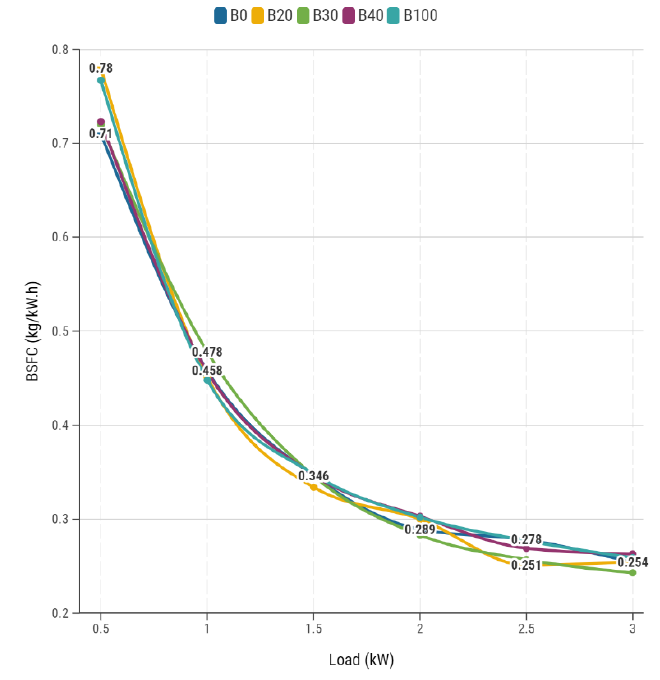
Figure 8. BSFC at different load.